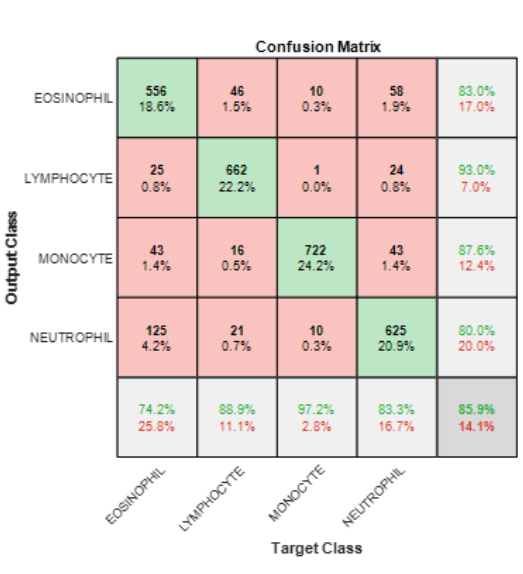
Figure 2. Confusion Matrix for CNN with 20 epochs